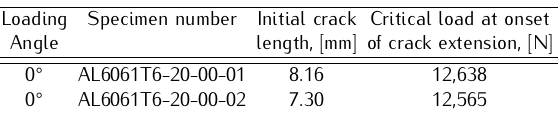
Table 1. InformationforArcantestson2.0mm-thickAL6061T6spec- imens. Loading Specimen number Initial crack Critical load at onset